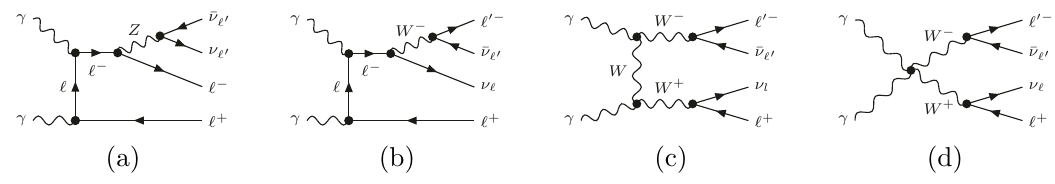
Figure 2 . Sample photon-induced LO diagrams for 2l-SF-ZZ (a) and 2l-DF-WW (b-d). There is no photon-induced LO contribution to